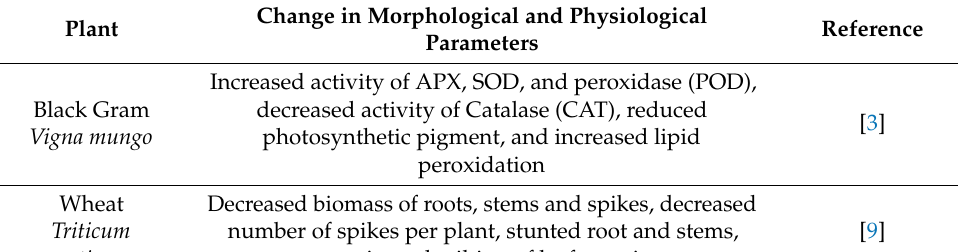
Table 1. Effect of arsenic on morphological and physiological parameters of different plants. Change in Morphological and Physiological Plant Parameters Increased activity of APX, SOD, and peroxidase (POD), Black Gram decreased activity of Catalase (CAT), reduced Vigna mungo photosynthetic pigment, and increased lipid Wheat Decreased biomass of roots, stems and spikes, decreased Triticum number of spikes per plant, stunted root and stems, aestivum necrosis, and wilting of leaf margins Decreased number of lateral roots, thickening and darkening of roots, necrotic and slimy root tips, darker and thicker stems, inhibited leaf development, affected Soybean biomass and root cell death, thin-walled parenchyma Glycine max cells, reduced root cortex area, increased total peroxidase and superoxide dismutase (SOD) activity in As(III) treatment compared to As(V), and